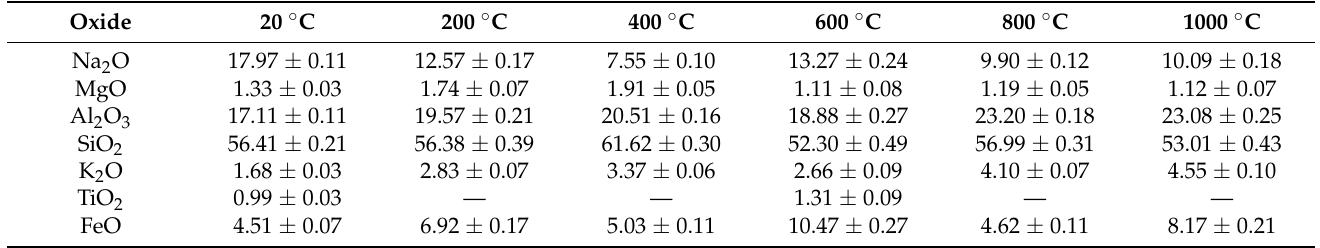
Table 5. Comparison of the oxides composition based on EDS of Al-2 from the surface presented on SEM pictures.